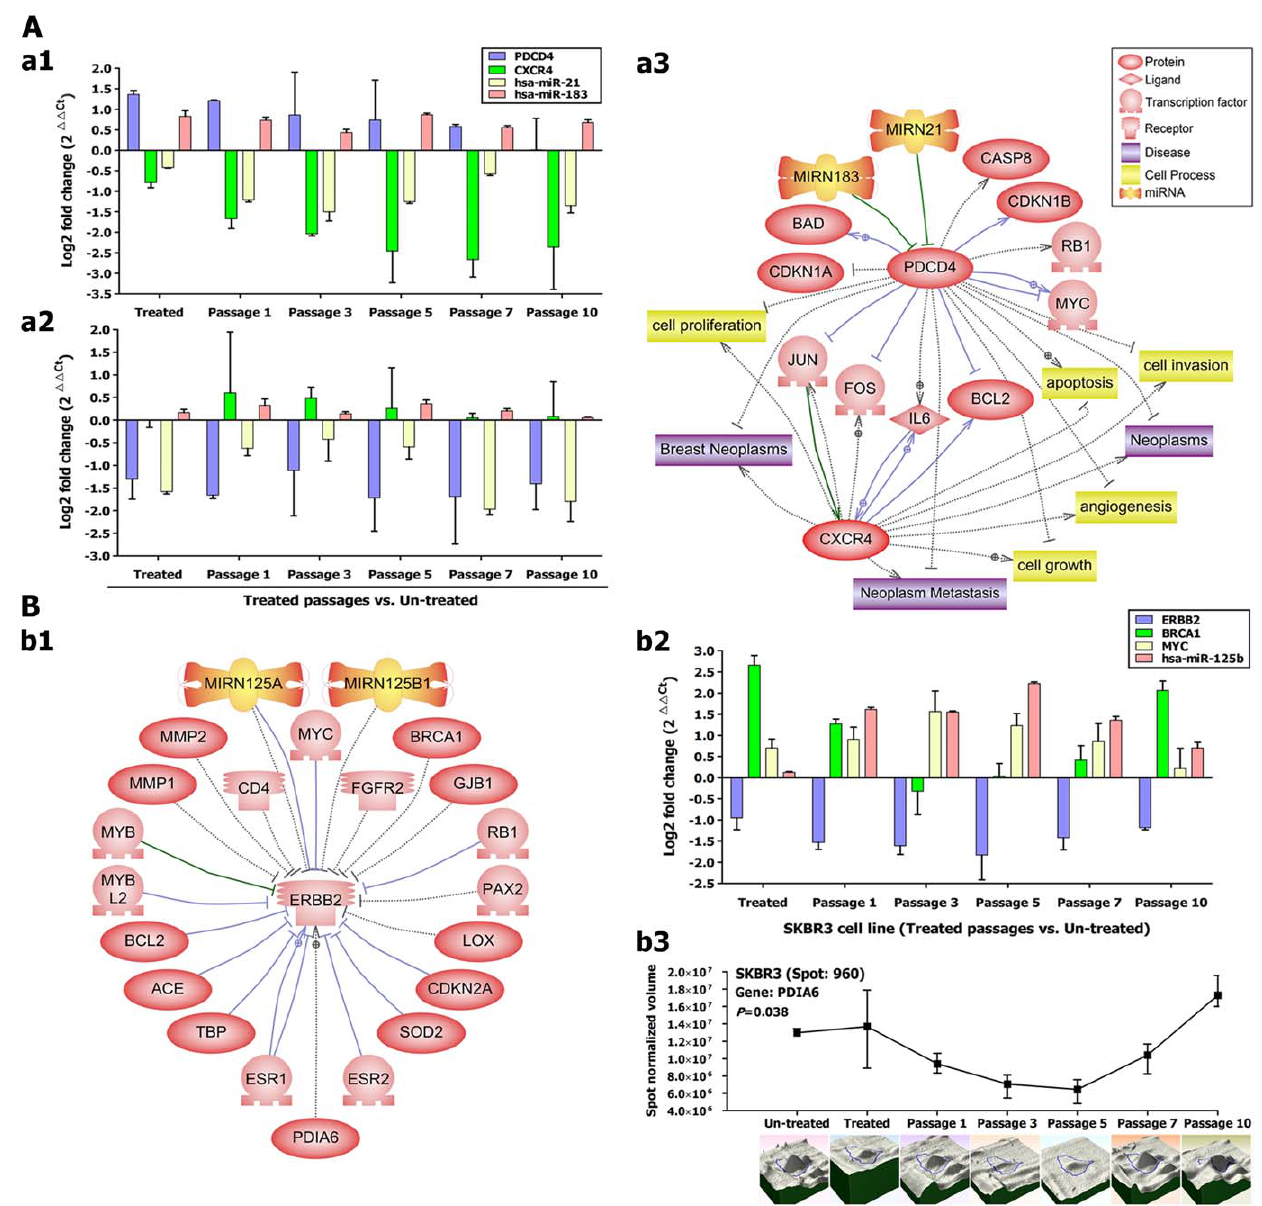
Figure 5. Dysregulation of important indicators of metastasis, prognosis and hormone receptors after treatment. A) Regulation of PDCD4 and CXCR4 genes as important indicators of metastasis and prognosis before and after treatment in two studied cancerous cell lines. a1-2) Expression profiles of PDCD4 and CXCR4 genes and regulatory microRNAs in MDA-MB231 and SKBR3 cell lines, respectively. a3) Pathway analysis predicts the role of PDCD4 and CXCR4 in cancerogenesis and shows the upstream regulatory miRNAs. B) Mechanism of ERBB2 receptor down- regulation in SKBR3 (non-aggressive breast cancer cell line). b1) Pathway analysis shows negative upstream regulators of ERBB2 gene and PDIA6 as an example of positive regulators. b2) Expression profiles of ERBB2 and some negative regulators ( BRCA1 , MYC and miR-125b) that demonstrated significant changes during treatment. b3) Expression profile of Pdia6 protein as a positive regulator of ERBB2 that is detected by proteomics analysis. doi:10.1371/journal.pone.0027355.g005 regulation of miR-28 in all three cell lines, miR-21 in both conclusion, most of the miRNAs with a role in drug resistance cancerous cell lines and miR-17 in the non-aggressive cell line were down-regulated (Table 2) which suggests a lower resistance (Table 2; Dataset S5). At least three miRNA families were up- control of miRNAs after drug treatment. regulated: MiR-638 in all three cell lines, miR-34a in the highly aggressive line, miR-424 in the non-aggressive line, in a concordance with previous reports [63]. Other miRNAs were down-regulated upon treatment with DAC in all cell lines (miR- control. This gene is frequently silenced (through hypermethy- 181a and -27b). In some instances, Let-7i and miR-221 presented lation of specific CpG islands in the promoter, mutation, different responses than reported in the literature [63]. In